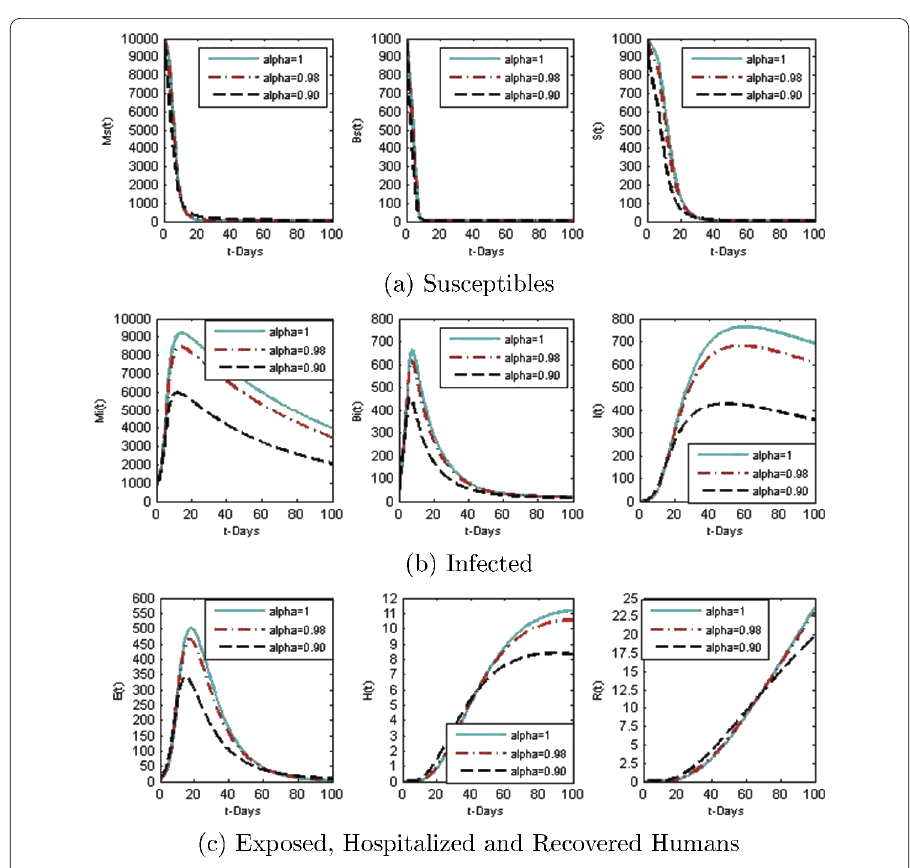
Figure 4 The approximate solutions of the fractional delay WNV model without control (i.e., u 1 = u 2 = 0) by using NSFDM. With d = 1 at different α , and (cid:7) t =